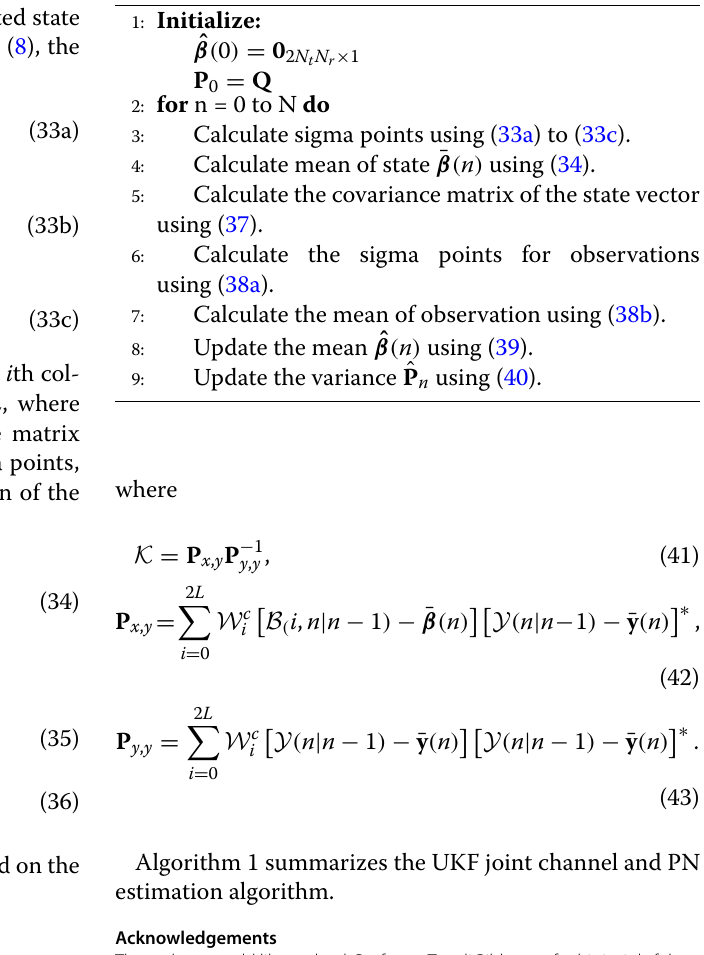
Algorithm 1 UKF for joint channel and PN estimation